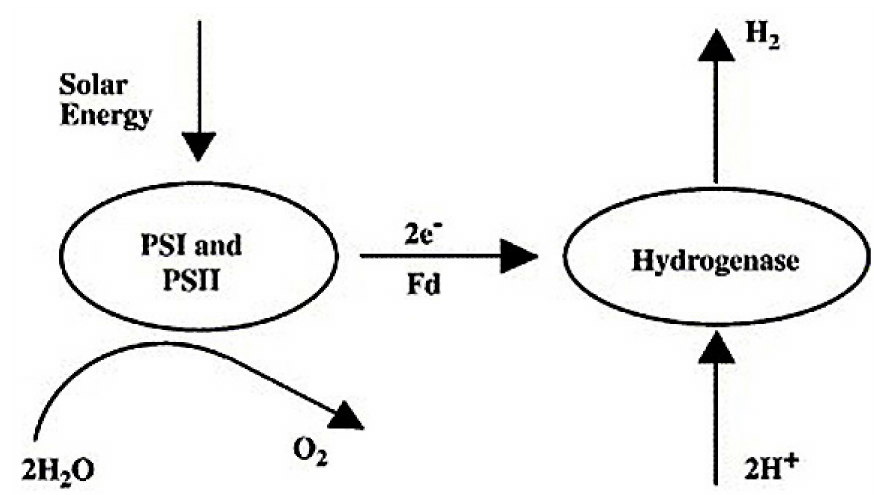
Figure 9. Representation of direct bio-photolysis [83]. Reproduced with permission from Elsevier, 2022.